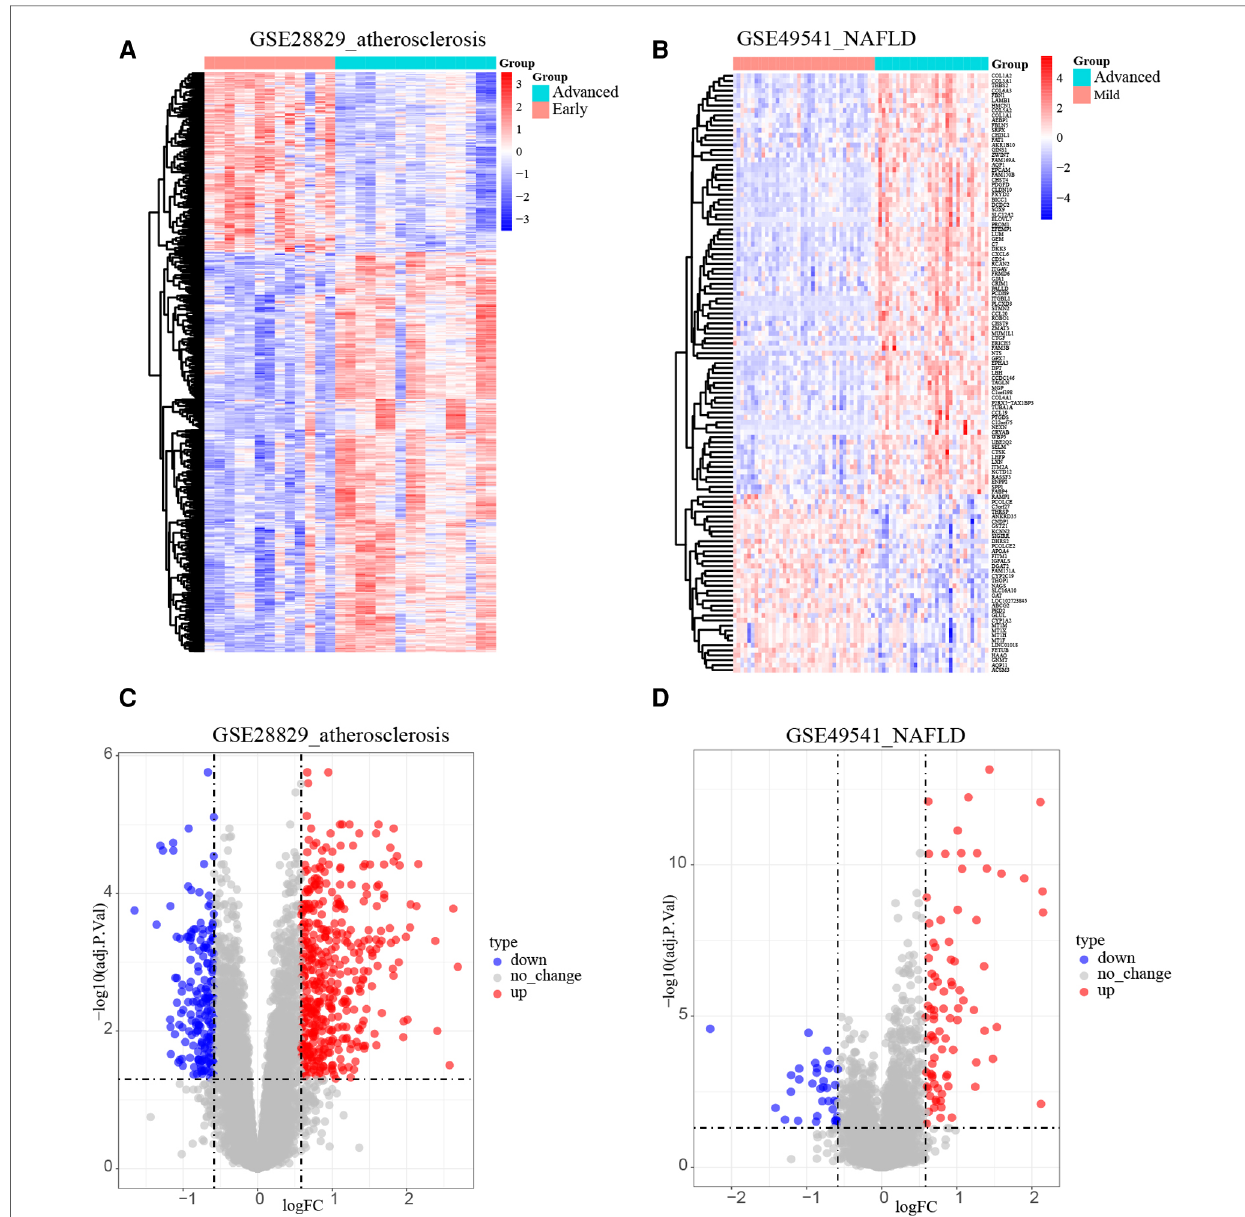
FIGURE 2 Identi fi cation of DEGs. ( A ) The heatmap of GSE28829; ( B ) the heatmap of GSE49541; ( C ) the volcano plot of GSE28829; ( D ) the volcano plot of